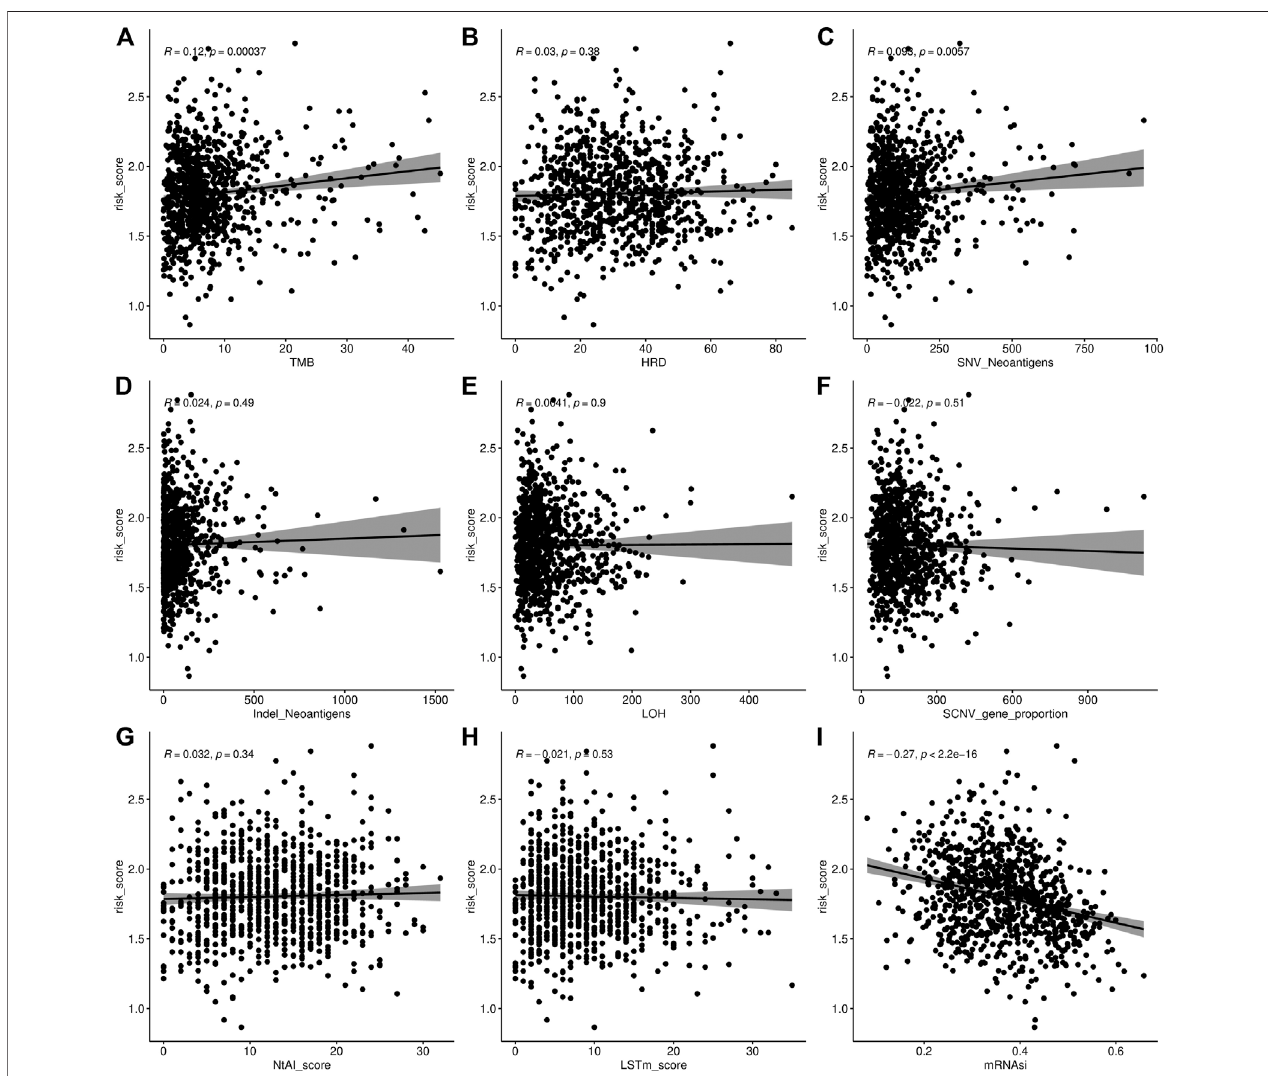
FIGURE 7 | Association analysis of AF risk score. (A) Tumor mutational burden and AF risk score. (B) Homologous recombination de fi ciency and AF risk score. (C – D) Neoantigen burden and AF risk score. (E) Loss of heterozygosity (LOH) in chromosome instability and AF risk score. (F) SCNV of chromosome instability and AF risk score. (G) Telomeric allelic imbalance (NtAI) of chromosome instability and AF risk score. (H) Large scale transition (LSTm) (I) Stemness index and AF risk score.